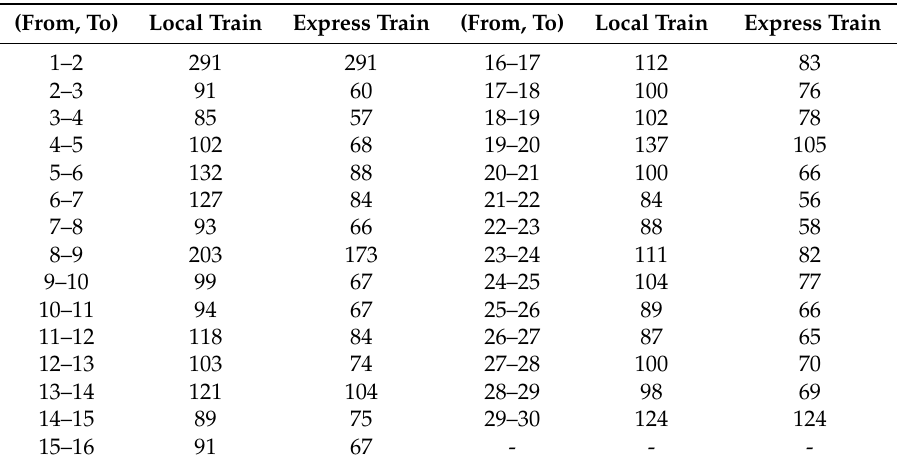
Table 1. Minimum transit times (seconds) of local and express trains. (From, To) (From,